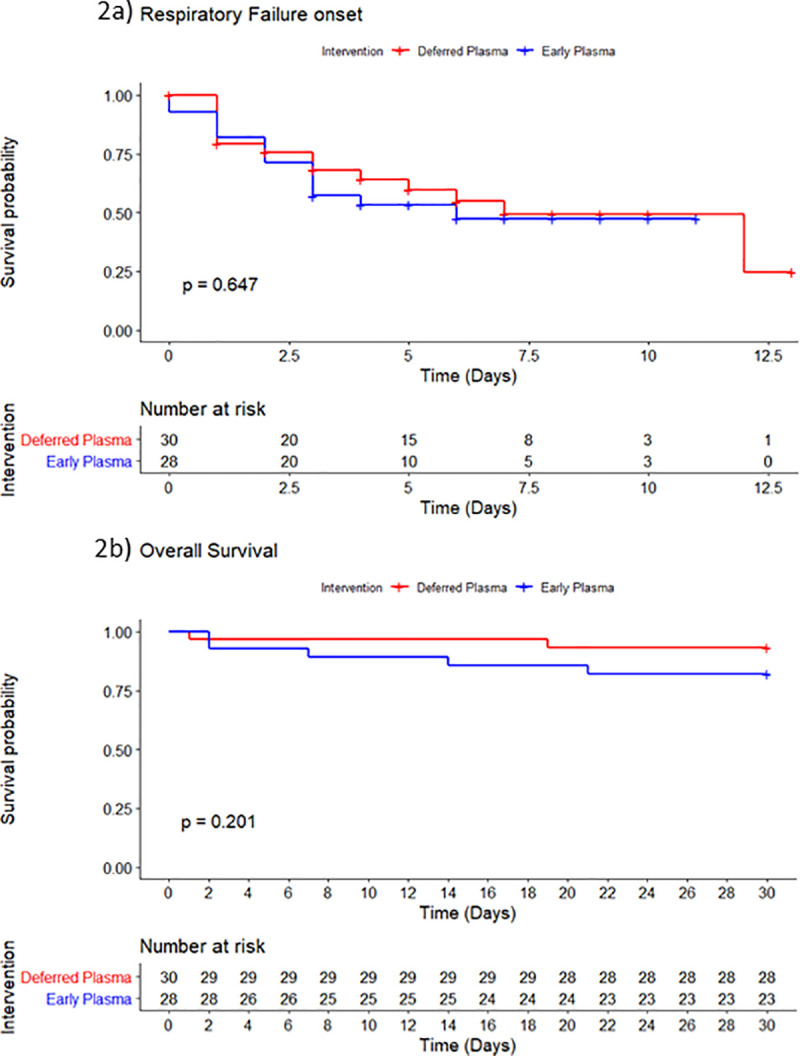
Time from enrollment to key secondary outcomes.(A) Time from enrollment to severe respiratory failure development (PaO2/FiO2 < 200) in the early plasma and deferred plasma groups. (B) Time from enrollment to death in the early plasma and deferred plasma groups.